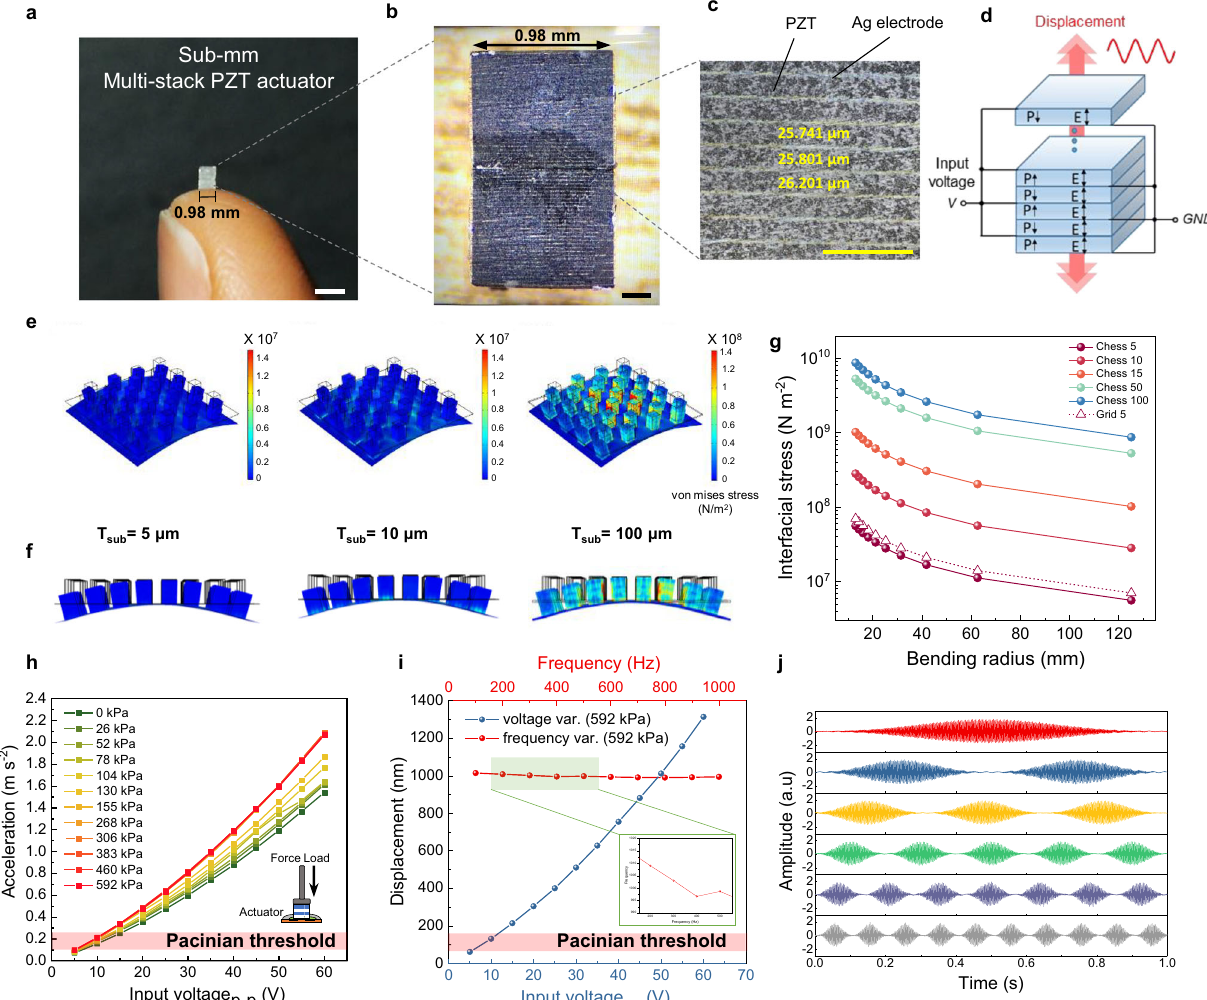
Fig. 3 Flexible sub-mm tactile actuator array for tactile rendering. a Image of a single actuator unit on a fi ngertip, scale bar is 2 mm. b Optical microscope image of sub-mm tactile actuator. Multi-stack piezoceramic block is miniaturized for high-resolution tactile rendering, scale bar is 200 μ m. c magni fi ed optical microscopic image of multi-layered piezoceramic actuator, scale bar is 100 μ m. d Schematic of multi- layered piezoelectric actuator and its operation mechanism. e FEM simulation of stress distribution in fl exible actuator arrays that have 3 different substrate thickness during bending. f side view of FEM simulation. g Sum of stress at the interface between actuator and substrate during bending. Stress is relieved by chessboard/diagonal arrangement (solid line) compared to square arrangement (dashed line). h output performance of a single actuator under increased pressure preloads while input voltage is applied from 5 to 60 V pp . i Frequency dependence of single actuator under pressure loading. Red line show output displacement under pressure loading while the frequency is changed from 100 to 1000 Hz. Blue line shows displacement under pressure loading while input voltage is changed from 5 to 60 V pp . Inset is a magni fi ed plot in frequency range 200 to 500 Hz. j Amplitude modulation of sub-mm piezo actuator for expression of static pressure feeling. Low frequency of 1 – 10 Hz has been demonstrated with a carrier frequency of 300 drive module using BLE. The module for the tactile actuator array tactile stimuli with high similarity and low delay. In the proposed is composed of an actuator driver, a microcontroller, and a BLE for telehaptic system, the tactile sensor and actuator were wirelessly generating vibrations in accordance with the transmitted sensor coupled by signal processing modules, as shown in Fig. 4. The signals. The actuator driver distributed voltage inputs to each module for processing and transmitting the sensor signals is actuator pixel with peak-to-peak voltage in the range of 40 V to composed of preampli fi ers, a microcontroller, and a Bluetooth 60 V, and it can generate maximum voltage up to 90 V. A LED low-energy (BLE), as shown in Fig. 4a, b. Pre-ampli fi ers for bimodal driver has been added to the actuator drive module to visualize pressure sensor array have been designed as two different circuits the tactile patterns regenerated via telehaptic communication for each sensing type. The static pressure was measured by a (Fig. 4c, d). voltage divider and a voltage follower circuit. The dynamic To measure the delay time of the wireless telehaptic system, a pressure was measured by using a high gain voltage-mode 50 Hz sine wave was applied to a dynamic sensor pixel using a piezoelectric ampli fi er, which can amplify pA-order charge vibrator. Moreover, then the vibration signal transmitted to an generation (Supplementary Fig. 11b, c). The static/dynamic actuator pixel 3 m away was evaluated using a 3D laser scanning pressure signals acquired from the bimodal tactile sensor have vibrometer (LSV) as shown in Fig. 4e. The delay time was 1.55 ms, been converted into digital signals using 12-bit Analog-to-Digital which was measured by comparing the signal applied to the Converter (ADC), and then wirelessly transmitted to the actuator